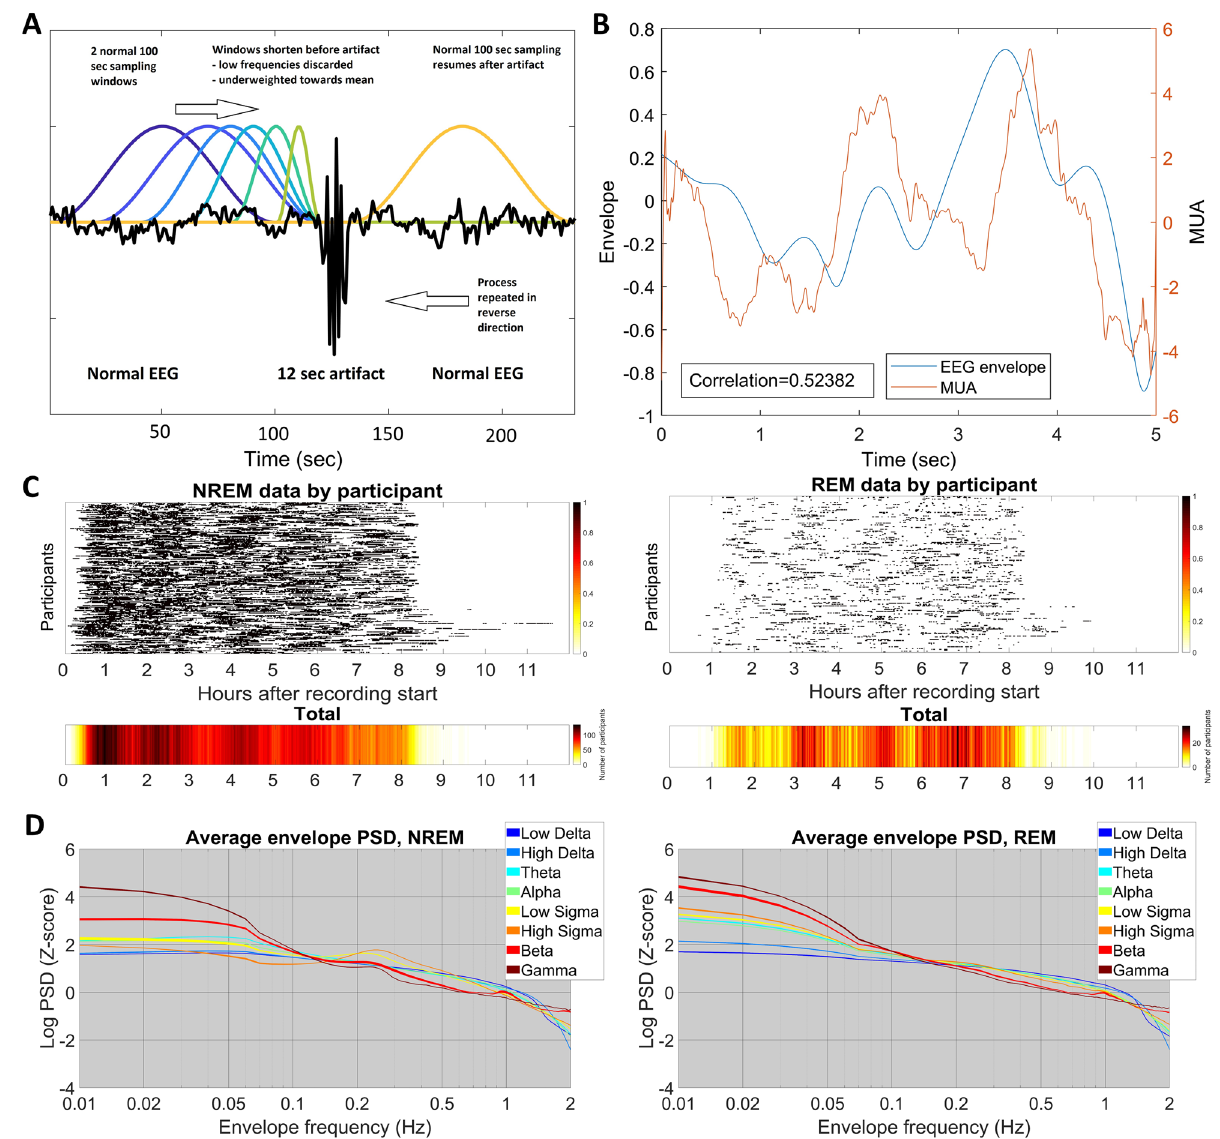
Figure 3. An illustration of EEG envelopes, the colliding window method and its results. ( A ) Illustrates the colliding window method. ( B ) Shows a single epoch of illustrative envelope and MUA data (ECoG low delta envelope and smoothed MUA from the fifth IME channel located in cortical layer III). The Pearson correlation of the two signals is shown for reference. Both the ECoG envelope and the MUA is detrended and demeaned, but not z-transformed. ( C ) Shows the distribution of available sleep data after artifact rejection using the colliding window method. For each participant, black lines mark the data segments used in analysis. The lower panel shows the total number of participants with available data as a function of time after recording start. Note the lack of systematic undersampling of any part of the night. ( D ) Illustrates the log-transformed envelope spectra. All data was z-transformed by frequency band to eliminate mean differences. The frequency axis is shown on a log scale to enhance the low frequency ranges which are of particular interest. Note spectral peaks at ~ 0.05–0.06 Hz, ~ 0.25 Hz and ~ 1 Hz, the latter most prominent in the beta